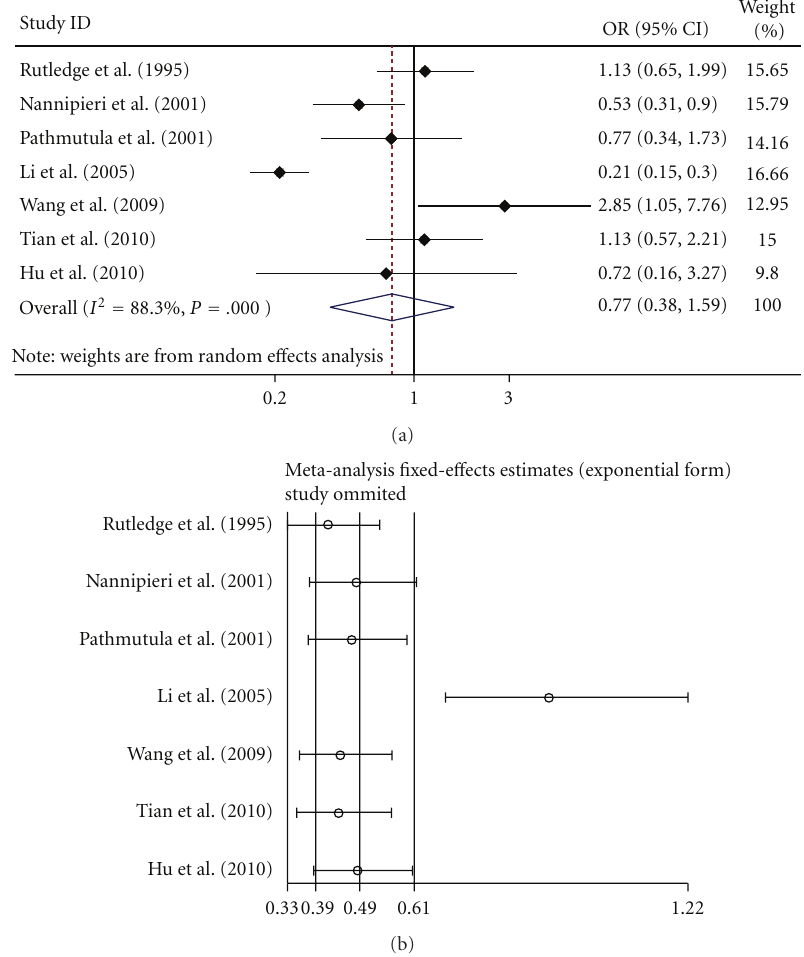
Figure 2: Overall risk estimate of ANP gene 2238C versus 2238T allele for hypertension (a) and the presentation of its influential analysis (b).